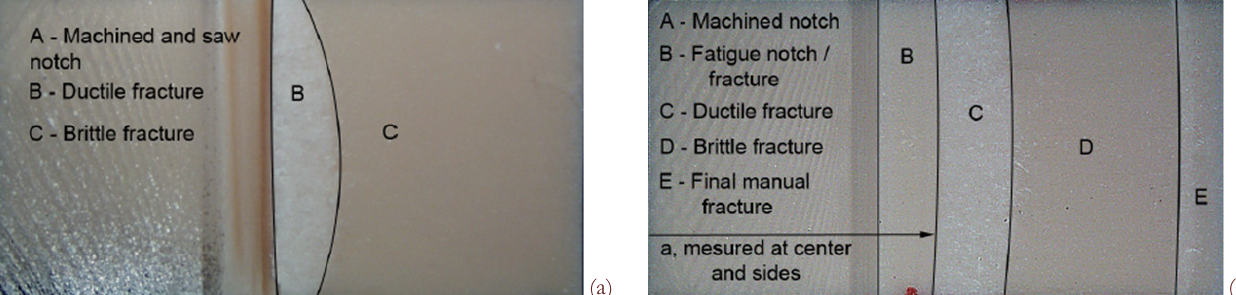
Figure 6: Typical fracture surfaces (adhesive 2015 with 10wt%) for of a specimen with a sawed crack (a) and with a fatigue pre-crack